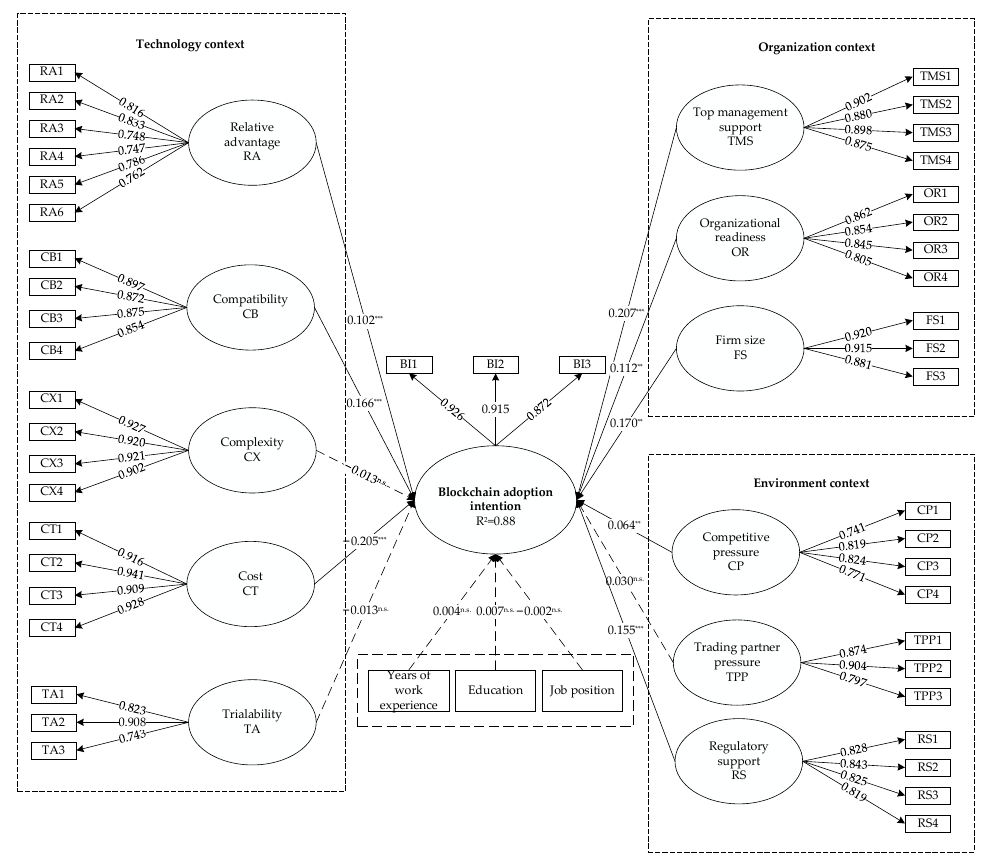
Figure 4. Structural path diagram for the hypothesized relationships. Notes: * p < 0.05; ** p < 0.01; *** p < 0.001; n.s. = not significant. Table 4. Calibration thresholds of the measures and causal necessary conditions